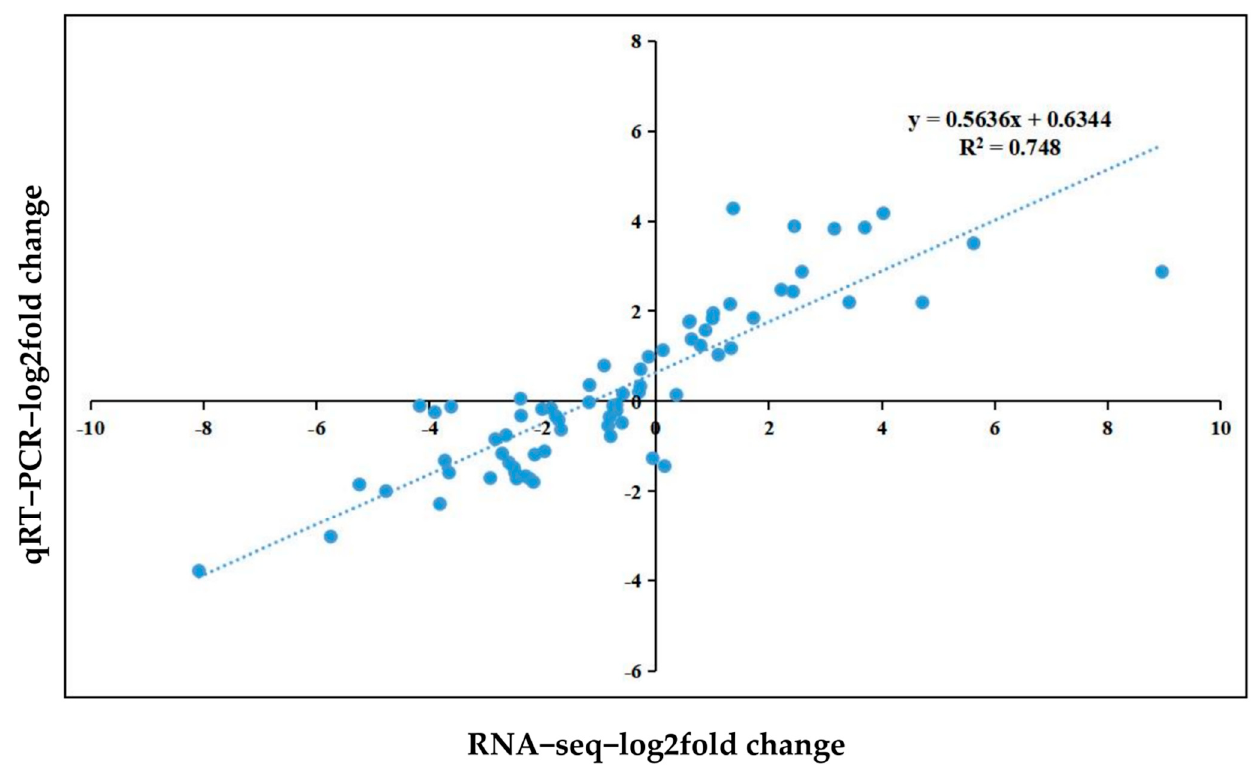
Figure 10. Correlation analysis between RNA-seq and qRT-PCR methods. Log2(fold change) values of RNA-seq data (x axis) are plotted against log2(fold change) values of qRT-PCR (y axis) data.